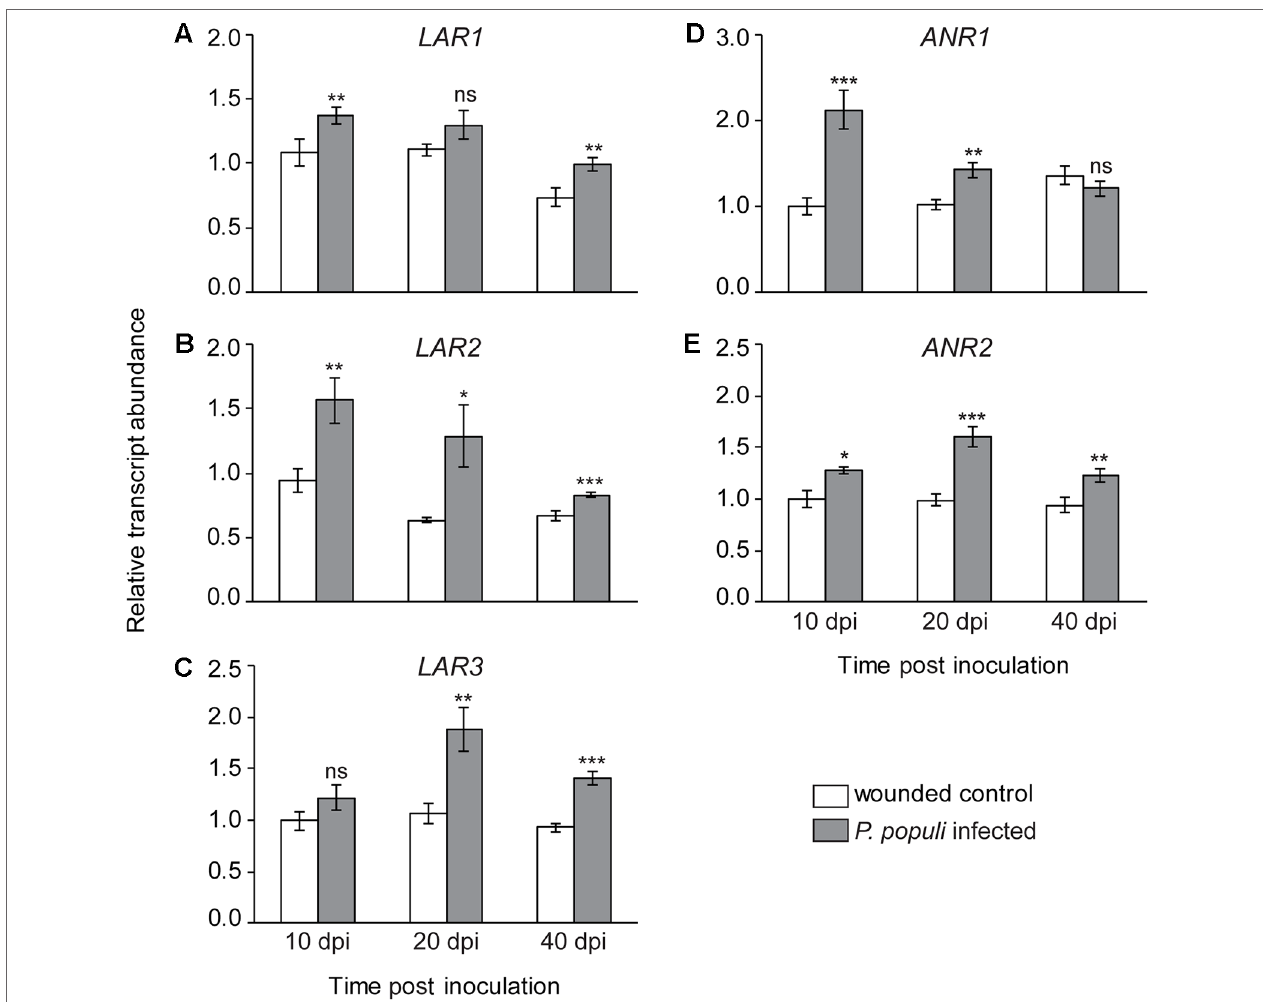
FIgURe 4 | Transcript levels of flavan-3-ol biosynthesis genes. (A – C) Leucoanthocyanidin reductase ( LAR ) and (D – e) anthocyanidin reductase ( ANR ) transcripts increase in black poplar stems after infection by P. populi compared to wounded controls. The LAR and ANR enzymes are involved in catalyzing the last steps of 2,3- trans -(+)-flavan-3-ol (e.g., catechin) and 2,3- cis -(−)-flavan-3-ol (e.g., epicatechin) biosynthesis, respectively. The mRNA levels of LAR and ANR genes were measured by qRT-PCR using two technical replicates per sample. Transcript levels of each gene were normalized to ubiquitin expression. Data were analyzed using Student’s t-test (*, p ≤ 0.05; **, p < 0.01; and ***, p < 0.001; ns, non-significant). Bars represent mean ± SE (n = 5). dpi, days post